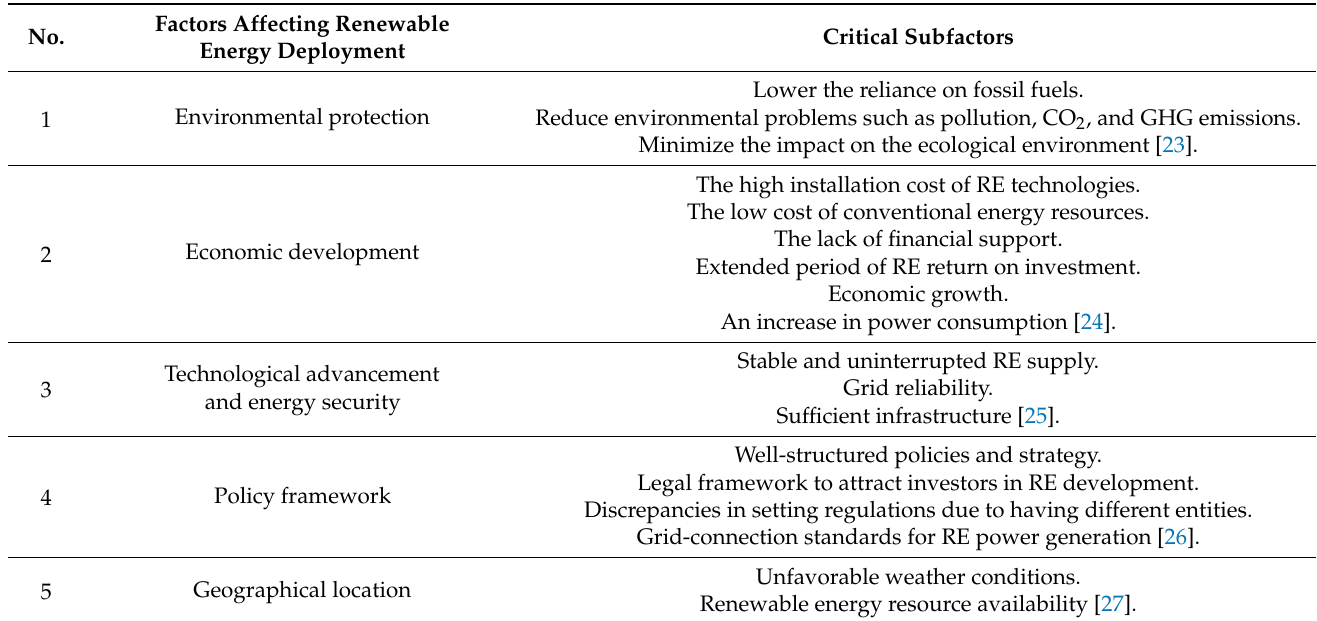
Table 1. Main Factors Impacting Renewable Energy